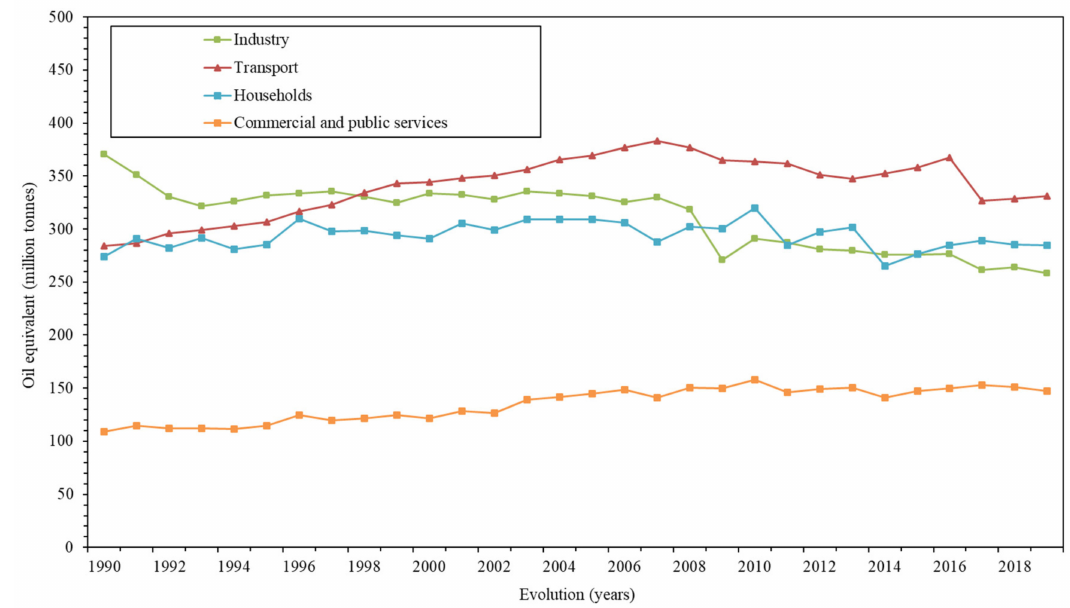
Figure 1. Final energy consumption per sector, European Union (EU)-28